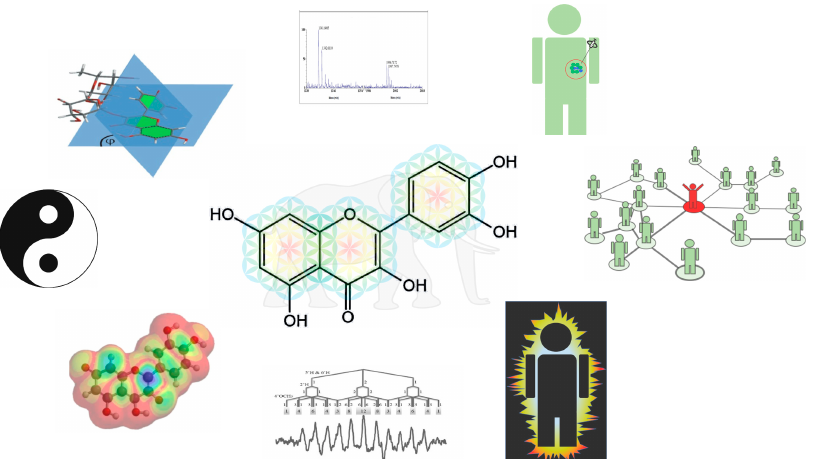
Figure 11. By combining the results obtained with different techniques and from different perspec- tives, a more complete picture of the redox modulating nature of flavonoids can be obtained. As in the metaphor, one then sees that it is not a tree, a wall, a snake or a rope; it is an elephant. When a closer look is given, one can see through the Yin and Yang and notice its connection to life. The figure is taken from the thesis of Zhengwen Li [36,37] .